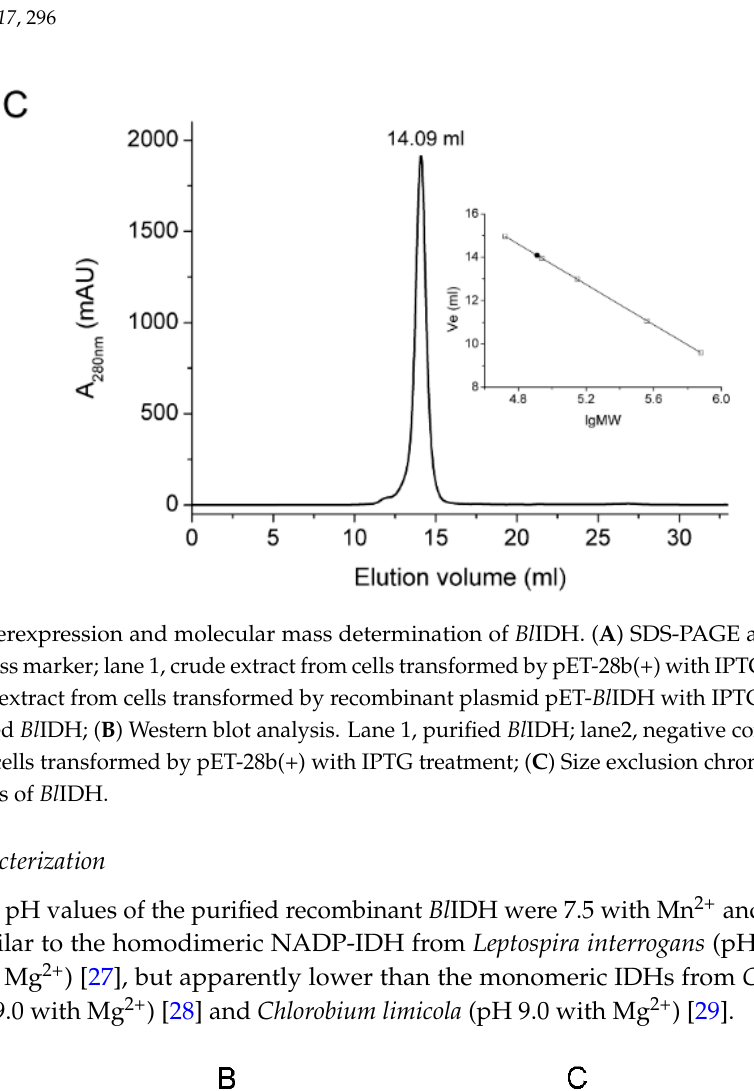
Table 1. Effects of metal ions on the activity of recombinant Bl IDH. Metal Ions